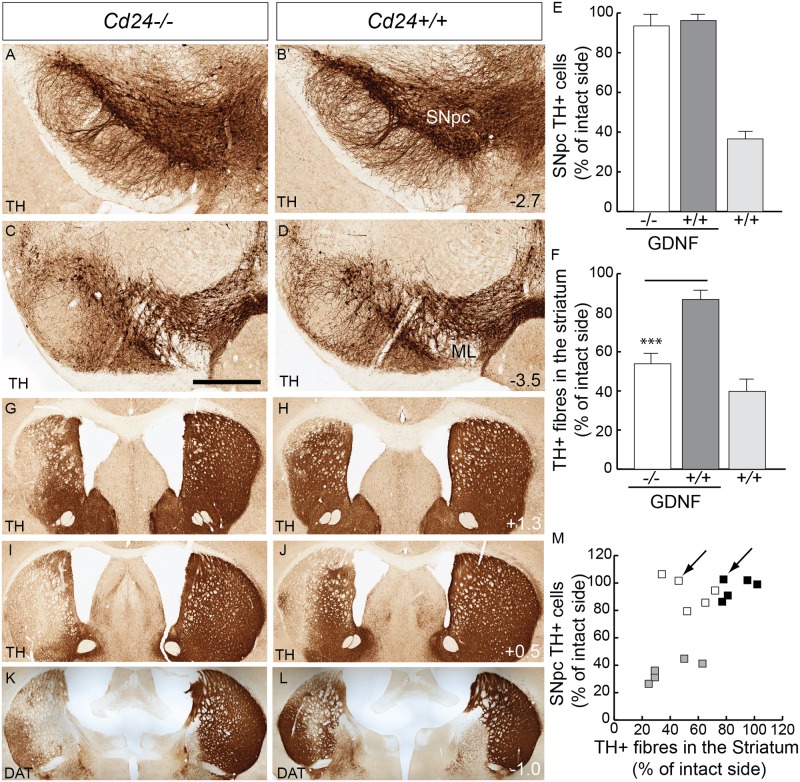
CD24 is important for the neuroprotective effect of GDNF on dopaminergic fibres, but not cell bodies, in the 6-OHDA striatal lesion model of PD.(A-D) Tyrosine hydroxylase (TH) immunohistochemistry on coronal sections of a midbrain from AAV-GDNF transfected—6-OHDA lesioned Cd24-/- mouse (left column) and a Cd24+/+ littermate (right column) at 12 days post-surgery, at the level of the rostral SNpc. (A&B) and caudal SNpc (C&D). (E) Stereological estimations of the number of SNpc TH+ cells found no difference with AAV-GDNF treatment in the 6-OHDA lesioned Cd24-/- and Cd24+/+ mice, but there is a severe reduction in the 6-OHDA only lesioned Cd24+/+ mice (controls). (F) Optical density analysis of the TH+ fibres in the striatum indicated a significant difference between the AAV-GDNF/6-OHDA lesioned Cd24-/- and AAV-GDNF/6-OHDA Cd24+/+ mice. (G-L) TH staining of fibre loss in the rostral (G and H), medial (I and J) and caudal (K and L) striatum from an AAV-GDNF/6-OHDA lesioned Cd24-/- mouse (left column) and a AAV-GDNF/6-OHDA Cd24+/+ littermate (right column). Panels K&L were stained with DAT, indicating that the effect was not specific for TH. (M) A dot-plot graph comparing the reduction in TH+ cells in the SNpc with the loss of TH+ fibres in the striatum. Black boxes represent Cd24+/+ that received both AAV-GDNF and 6-OHDA, white boxes represent Cd24-/- that received both AAV-GDNF & 6-OHDA, and grey boxes represent Cd24+/+ (controls) that received only 6-OHDA. The arrows in panel M indicate the two mice that are presented in panels A-D & G-L. The scale bar in panel D represents 400μm in panels A-D, and 800μm in panels G-L.